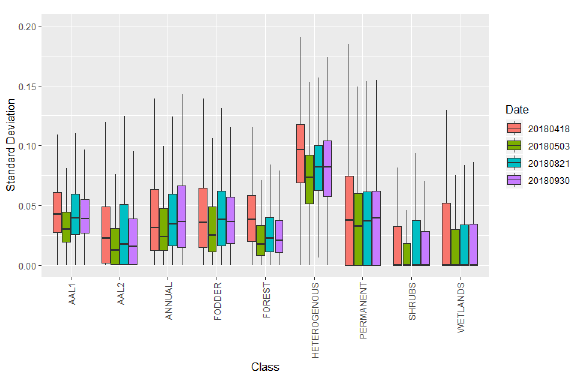
Figure 7. Spatial distribution of classified classes